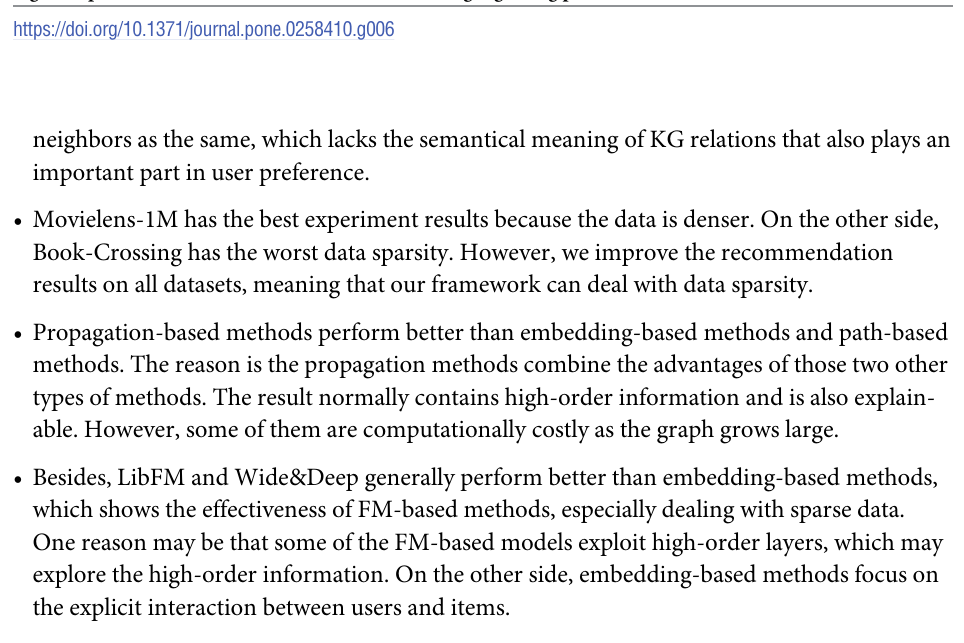
Fig 6. Top K recommendation result for Book-Crossing regarding precision and recall.